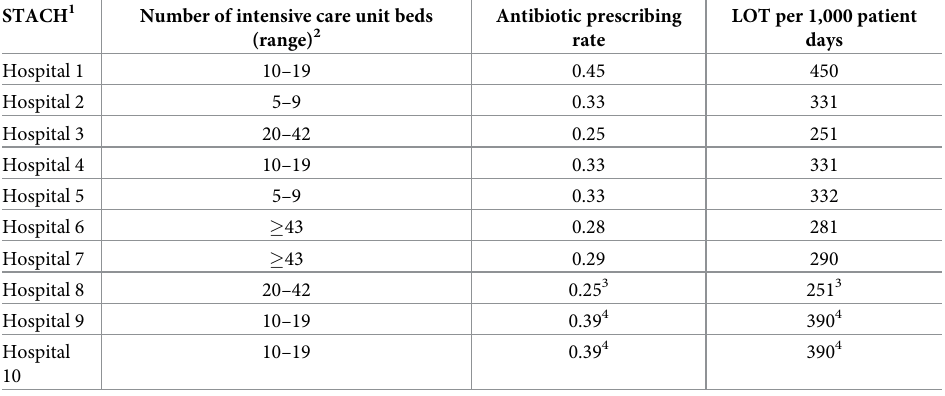
Table 2. Antibiotic prescribing rates and length of therapy (LOT) per 1,000 patient-days among admissions to network short-term acute care hospitals (STACHs). STACH